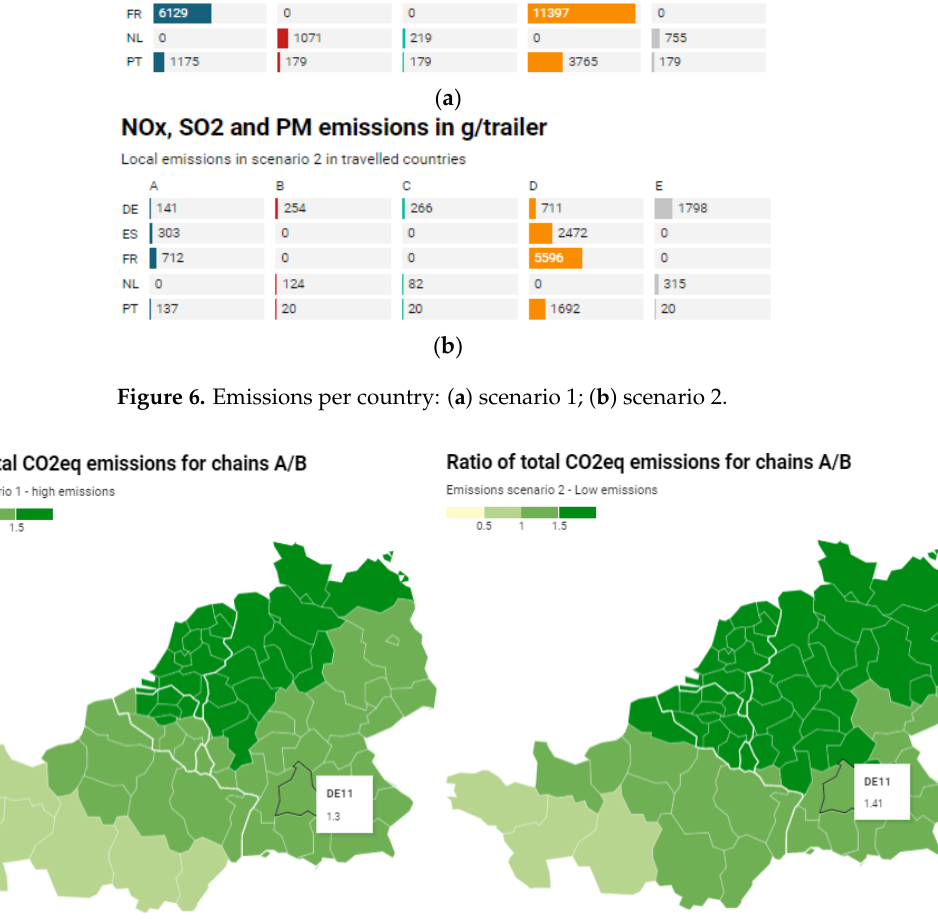
Figure 7. Ratio of CO 2 -eq between unimodal chain A and intermodal SSS-based chain B: ( a ) scenario 1; ( b ) scenario 2 (created with Datawrapper).